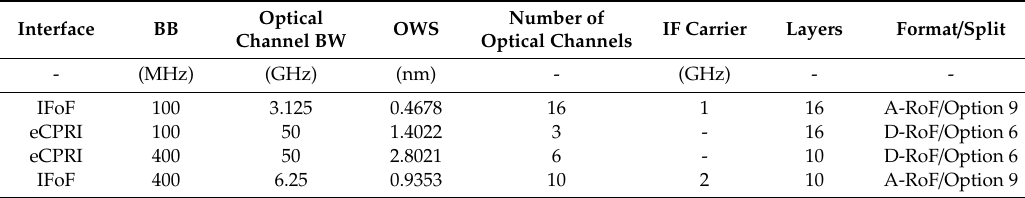
Table 8. Calculated comparative parameters for detailed scenario No. 6 to switch from D-RoF to A-RoF format (the optical channel count-down is starting from wavelength equal to 1675 nm)—Figures 10 and 12 (32-element antenna-array and 4-sector